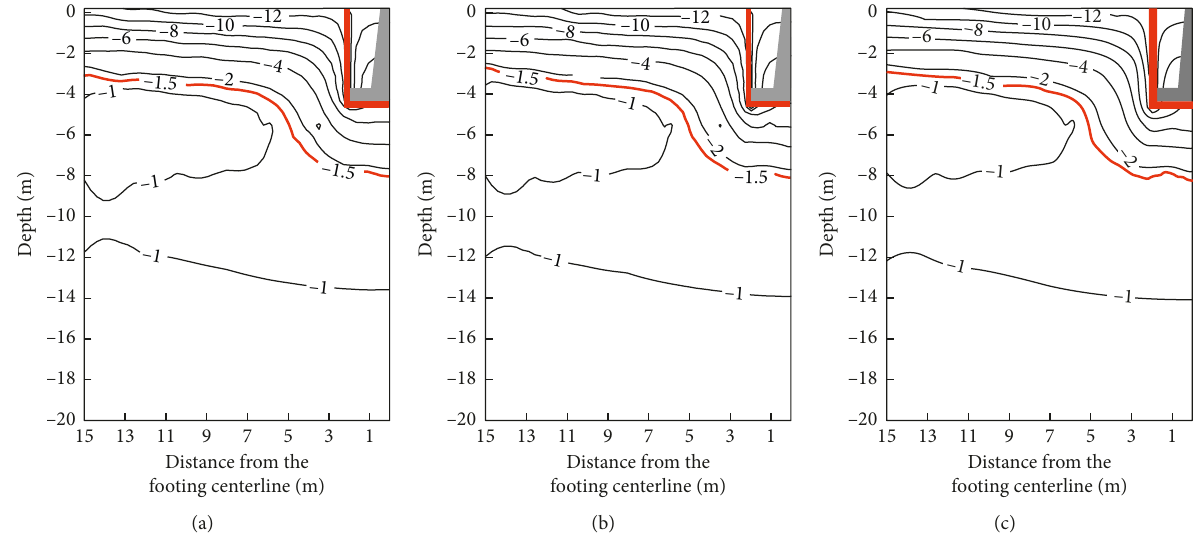
Figure 8: Temperature distributions of the duct-ventilated tower foundation on January 15 with different depths. (a) H